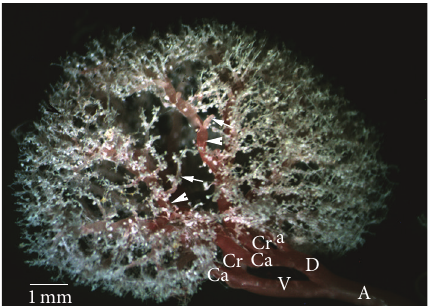
Figure 2: Ventral view of the intrarenal branches of the renal arteries, Type Ia. A: renal artery; V: the ventral branch of renal artery; D: the dorsal branch of renal artery; Cr: the cranial division of the renal artery; Ca: the caudal division of the renal artery; white arrowhead: interlobar arteries; arrow: arcuate artery, black arrowhead; interlobular arteries.